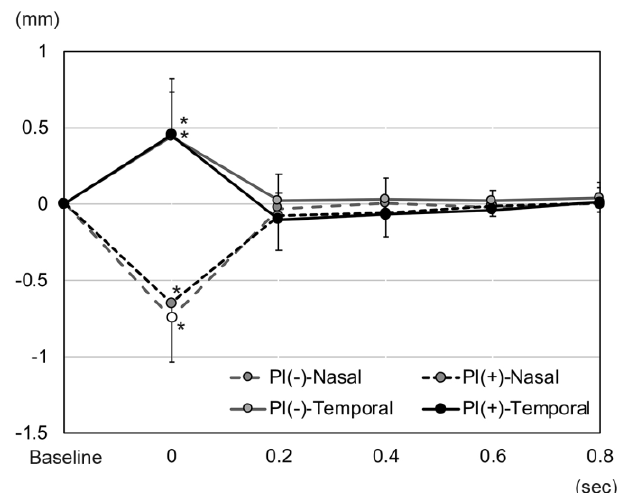
Figure 5. Changes in the height of the iris in the eyes after intrascleral fixation with and without peripheral iridectomy (PI). The nasal height of the iris in eyes with and without PI is significantly lower than the baseline position at 0 s and returned to the baseline position at 0.2 s (* p < 0.01). The temporal height in eyes with and without PI was significantly higher than the baseline position and also returned to the baseline position at 0.2 s. The nasal and temporal height of the iris in eyes with PI was not significantly different from that without PI at any time